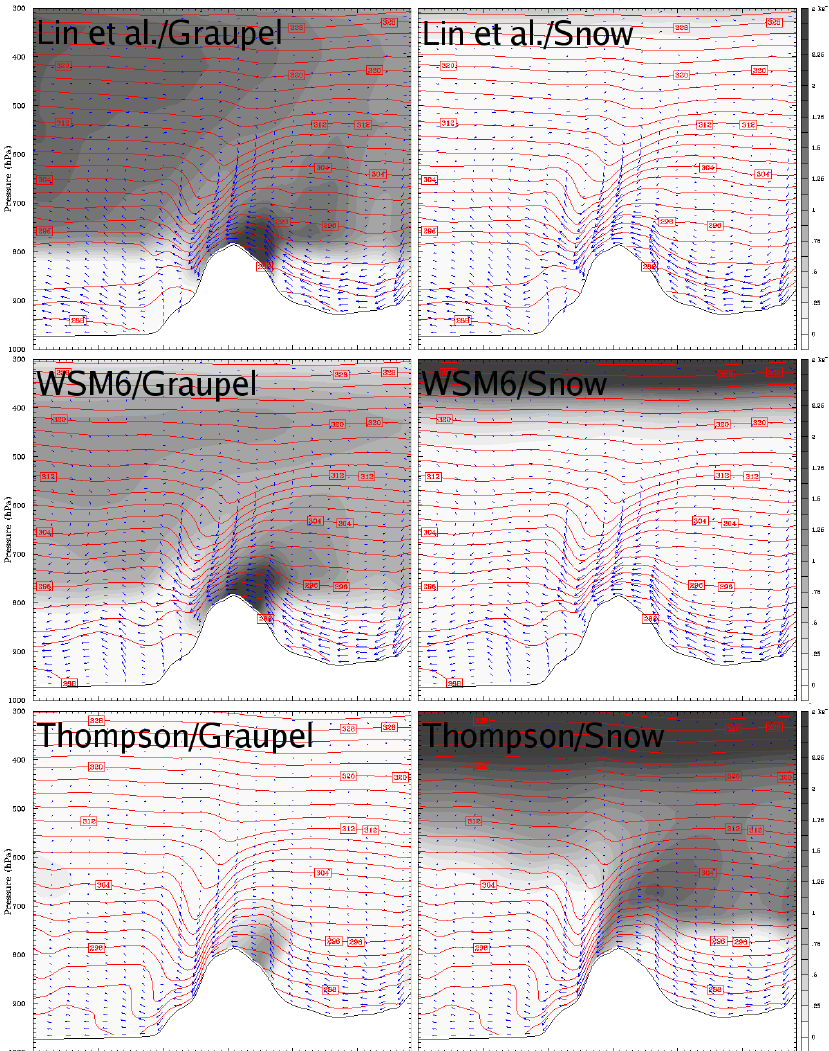
Figure 10: Cross section along line AB (cf. Fig. 4) showing potential tempera- Fig. 10. Cross section along line AB (cf. Fig. 4) showing potential temperature (red lines) [K], wind along cross section (blue arrows) [ms − 1 ], ture (red lines) [K], wind along cross section (blue arrows) [ms − 1 ], graupel mix- graupel mixing ratio [g/kg] (left columns) and snow mixing ratio [g/kg] (right column) at 09:00UTC 16 September 2004. micro-physics ing ratio [g/kg] (left columns) and snow mixing ratio [g/kg] (right column) at schemes are Lin et al. (top), WSM6 (middle) and Thompson 0900 UTC 16 September 2004. micro-physics schemes are Lin et al. (top), WSM6 (middle) and Thompson (bottom).